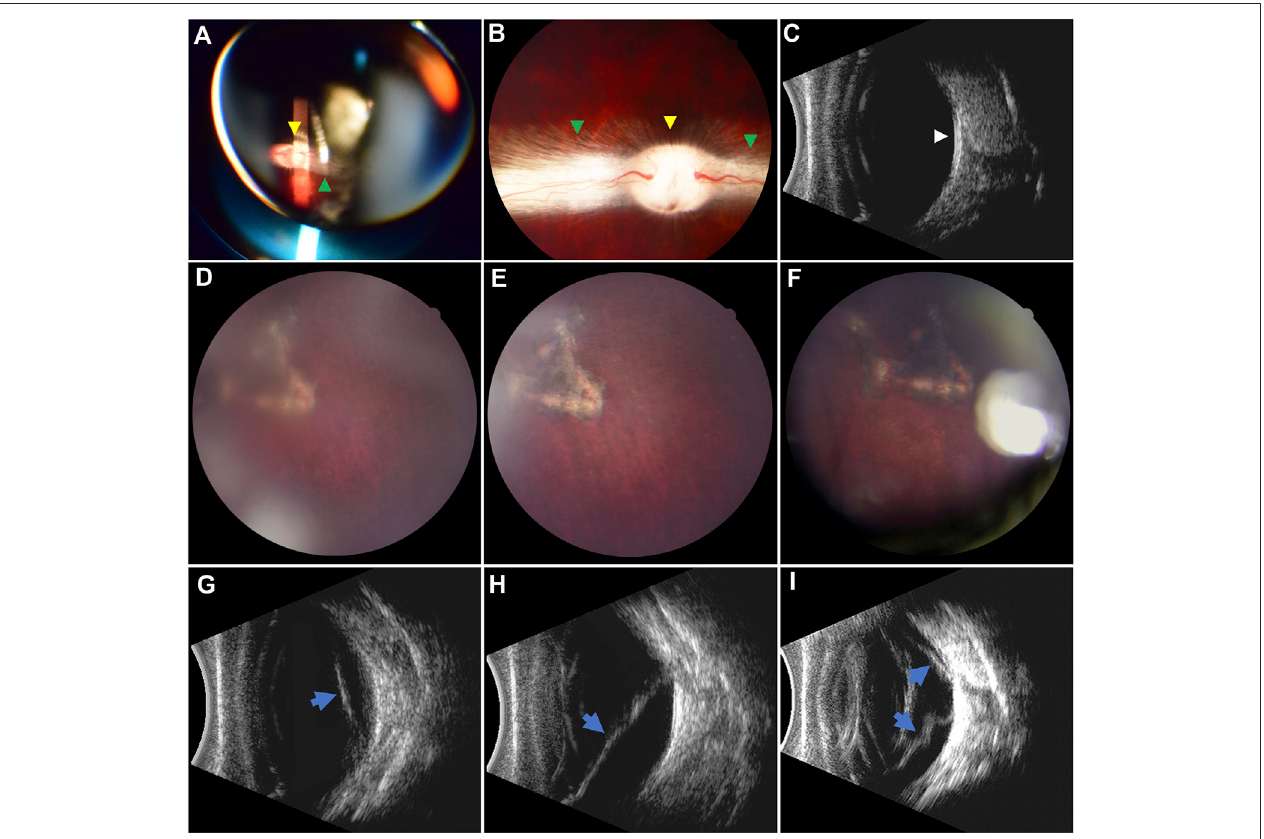
FIGURE 7 | Pre- and postoperative fundus examination. (A – C) Preoperative fundus examination via indirect ophthalmoscopy, fundus photography, and B-mode ultrasound, respectively. The optic disc (yellow arrowheads) and myelinated nerve fi bers (green arrowheads) were well-marked. The vitreous cavity was clear, and the retina was attached (white arrowhead) in the ultrasound image. (D – F) Retinal reattachment in the RRD-hydrogel group at 7 days and 1 and 3 months after surgery, respectively. Pigmentation around the retinal break was apparent. (G – I) Retinal detachment (blue arrows) in the RRD group at 7 days and 1 and 3 months after surgery, respectively. The localized retinal detachment (G) extended (H) and gradually became stiff from a soft state over time (I) .